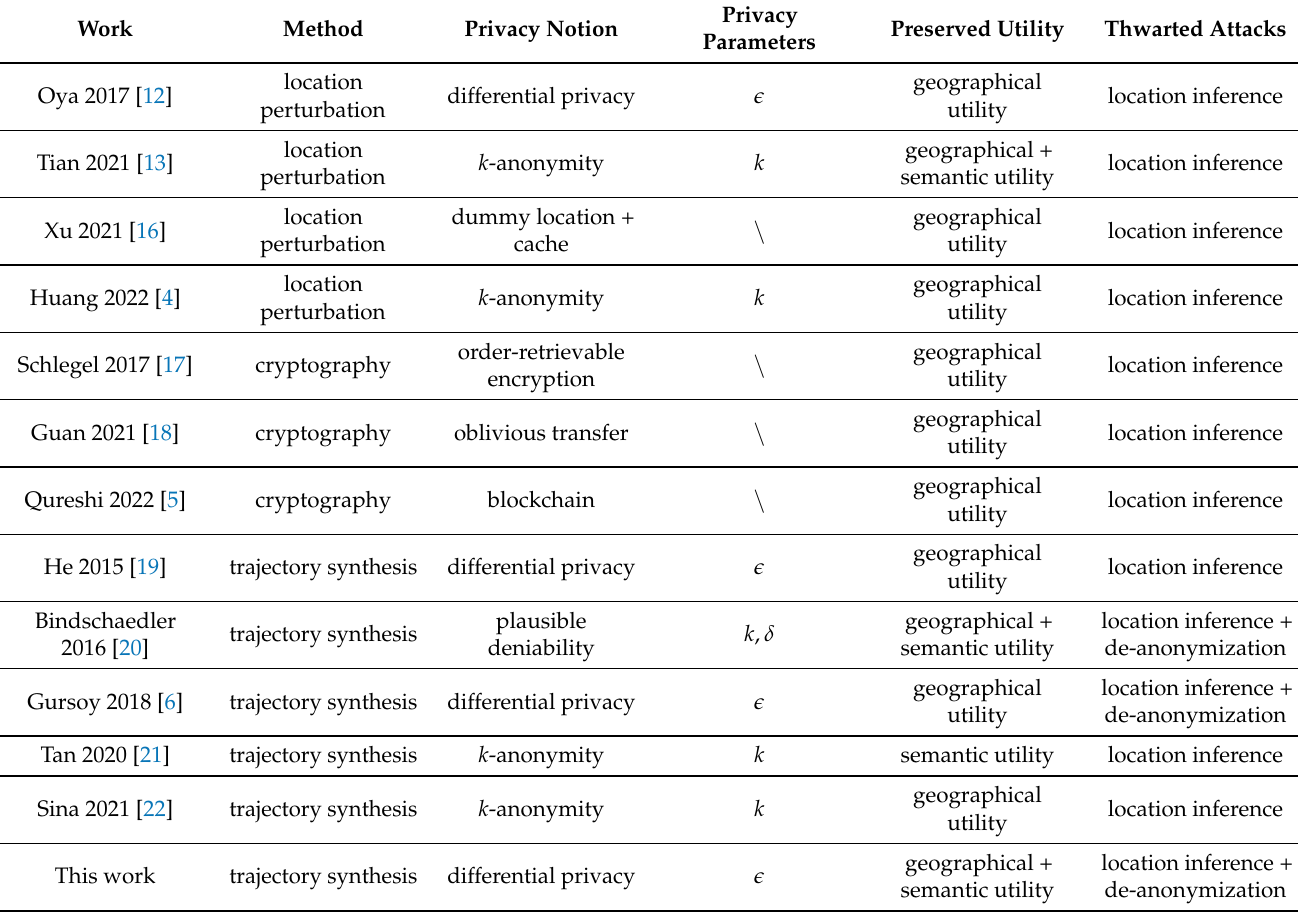
Table 1. Summary of related work in terms of location privacy